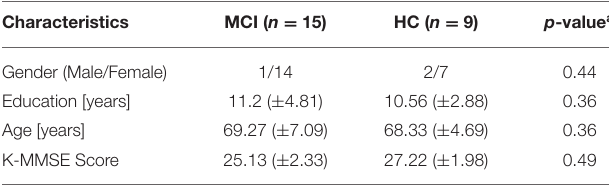
TABLE 1 | Demographic information of participants. Characteristics